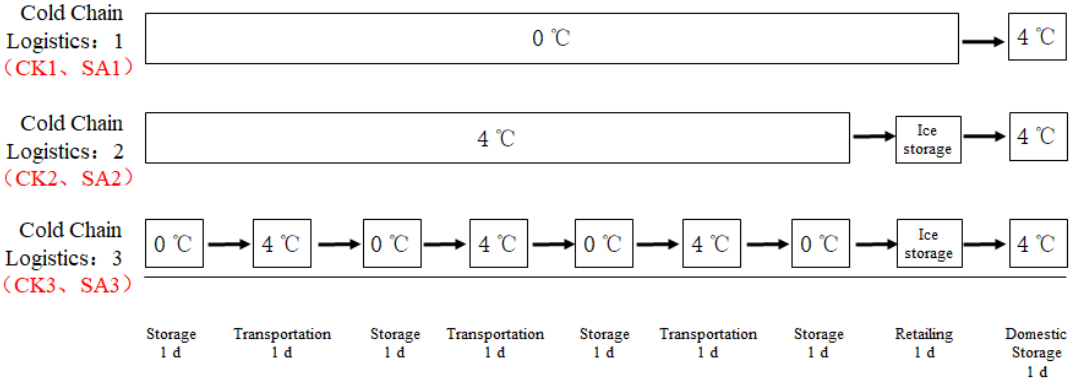
Figure 1. Simulated situation of temperature changes in cold chain logistics process of Pacific white